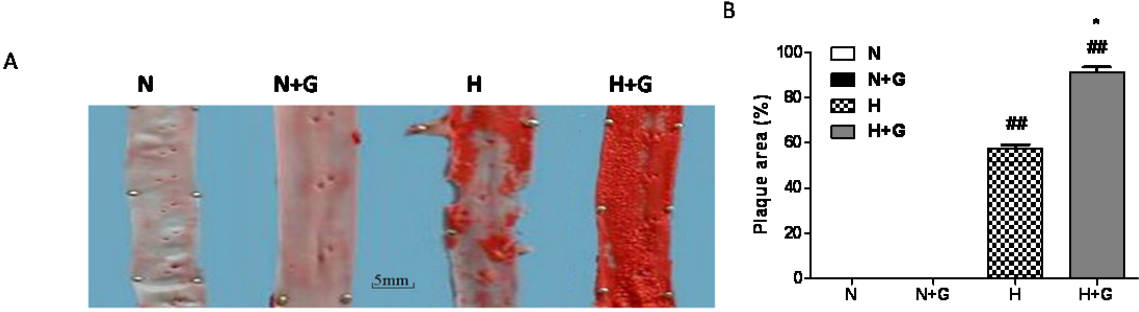
Figure 1. The effect of granulocyte-colony stimulating factor (G-CSF) on atherosclerosis in thoracic aortae. ( A ) Representative photographs of Sudan III-stained thoracic aortae; ( B ) Quantitative analysis of the plaque area in thoracic aortae. Plaque area was evaluated as the percentage of lesion area of the total surface area of intima. A, Scale bar: 5 mm. N: normal diet group, N + G: normal diet group treated with G-CSF, H: high-fat diet group, H + G. high-fat diet group treated with G-CSF. Results were expressed as means ± SEM. N ≥ 3. * p < 0.05, normal diet +G-CSF vs. normal diet group, or high-fat diet +G-CSF vs. high-fat diet group; ## p < 0.01 high-fat diet group vs. normal diet group or high-fat diet +G-CSF vs. normal diet